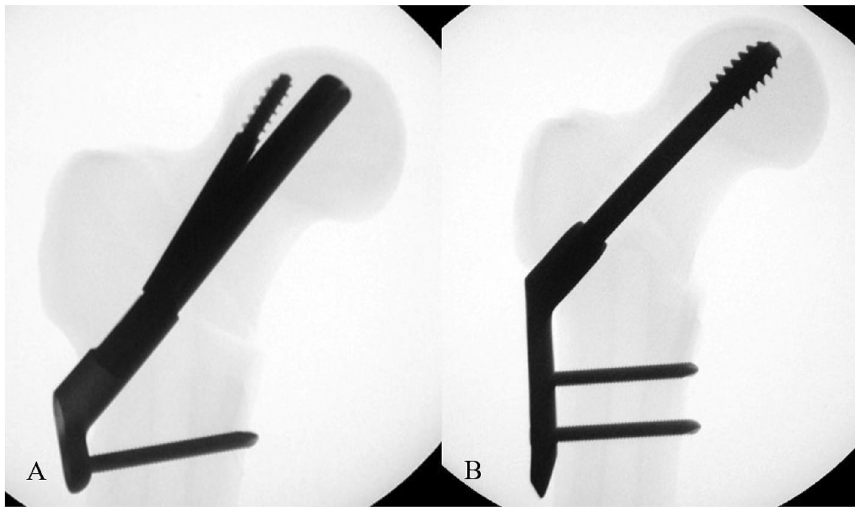
Figure 3. Each specimens in FNS group ( a ) and DHS group ( b ) showed by